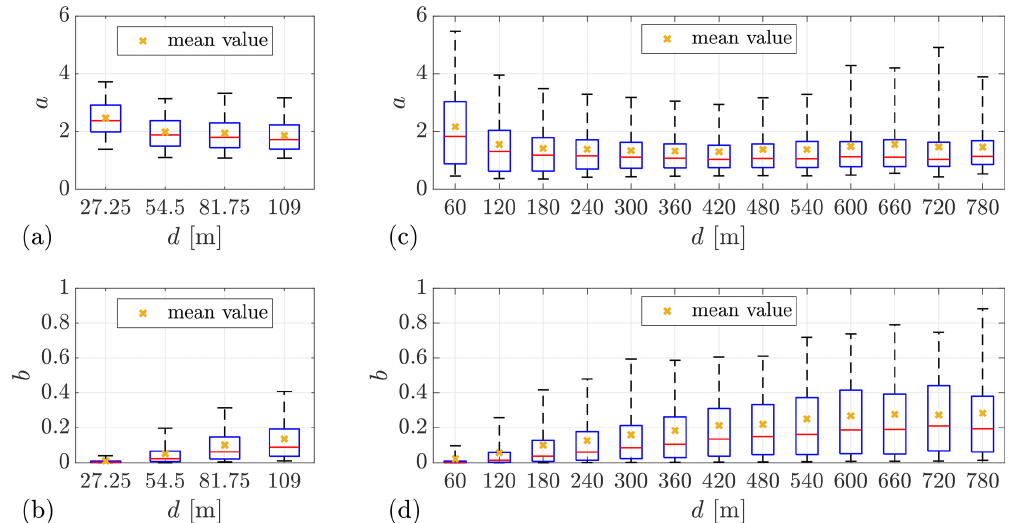
Figure 8. Box plots of the wind evolution model parameters grouped by the measurement separations d . (a, b) Lidar Complex. (c, d) Park- Cast. The bottom and top of the boxes indicate the first (25th percentile) and third (75th percentile) quartiles. The lower and upper whiskers show the 5th and 95th percentiles. The red line in the middle indicates the median value. Minimum sample size is 50.